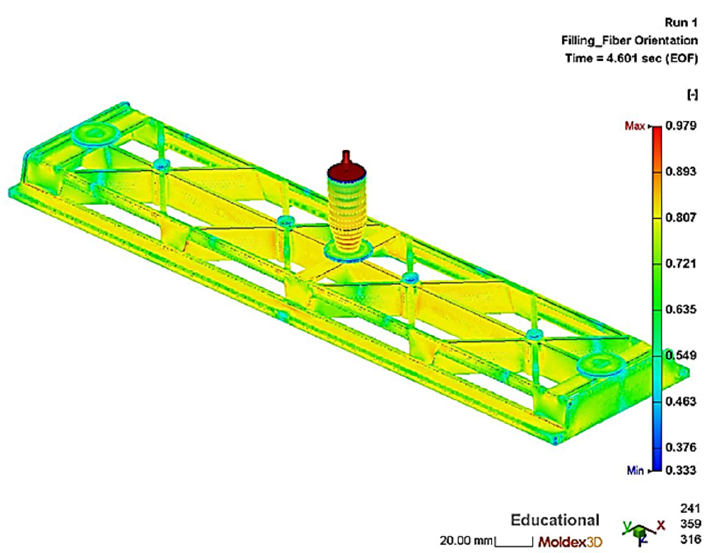
Figure 9. Simulated fiber orientation of the PP/GF30 short fiber-reinforced thermoplastic composite overmolding material in the hybrid test structure.